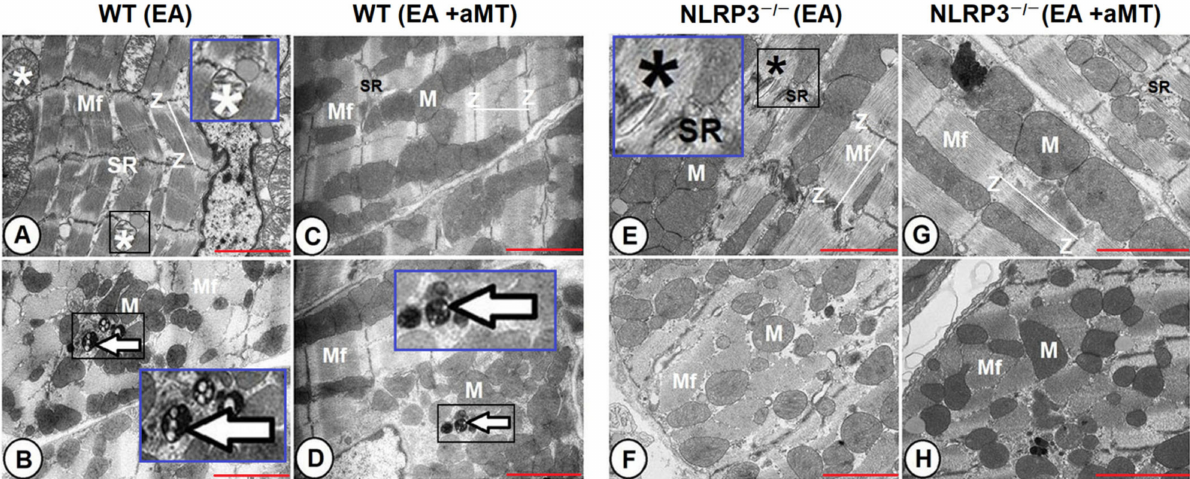
Figure 5. Impact of NLRP3 absence and melatonin treatment on the ultrastructure of early-aged cardiac myocytes. ( A , B ) Transmission electron micrographs of the LV of the EA WT mice showing disorganized myofibrils (Mf) and sarcoplasmic reticulum (SR). Some mitochondria displayed vacuolation and cristae damage (white asterisk), with appearance of small- sized multivesicular bodies (arrow). Higher magnifications of the black boxed areas in the blue insets. ( C , D ) Transmission electron micrographs of the LV of the EA WT mice after melatonin supplementation. The cardiac myofibrils (Mf) maintained the normal orientation, with intact mitochondrial contents (M), organized sarcoplasmic reticulum (SR), and reduced residual bodies (arrow). Higher magnification of the black boxed area in the blue inset. ( E , F ) Transmission electron micrographs of the LV of the EA NLRP − / − mice revealing absence of age-related alterations in the myofibrils architecture (Mf), sarcoplasmic reticulum (SR), and mitochondrial composition (M), except presence of individual disorganized myofibrils with indistinct striations (black asterisk). Higher magnification of the black boxed area in the blue inset. ( G , H ) Transmission electron micrographs of the LV of the EA NLRP − / − mice with melatonin therapy demonstrating improvement of myofibrils (Mf) and their sarcoplasmic reticulum (SR) and mitochondrial contents (M). Note sarcomeres arrangement between each two successive Z-lines (Z). Bar “red line” = 2 µ